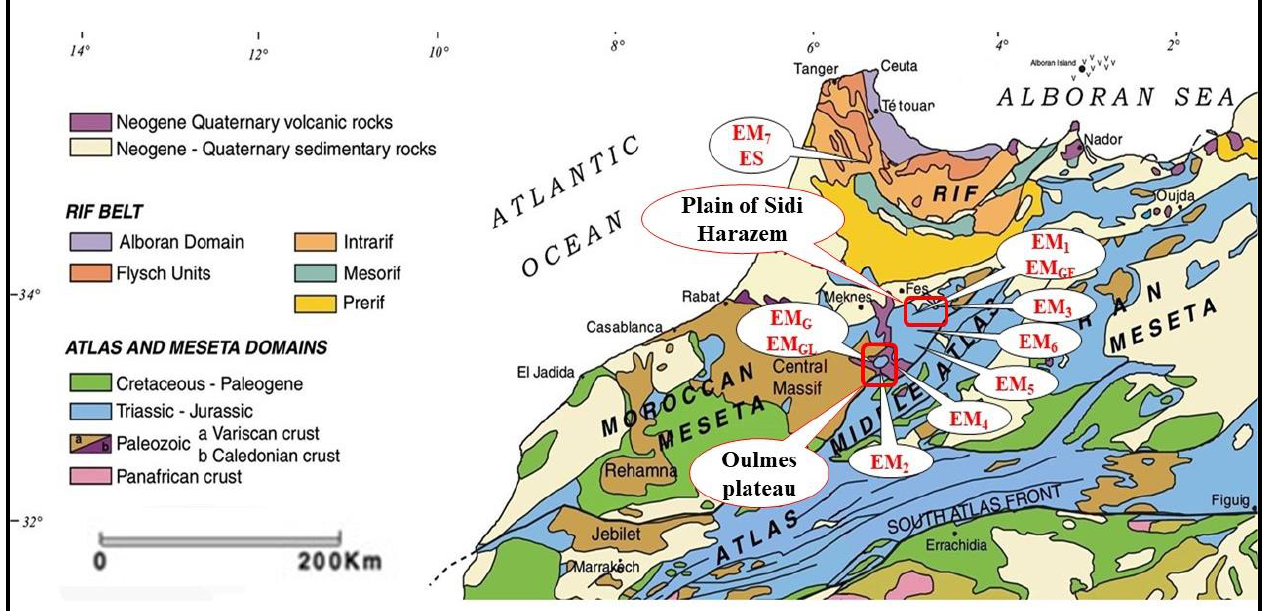
Figure 2. Geological map of the study area and the location of samples [22].